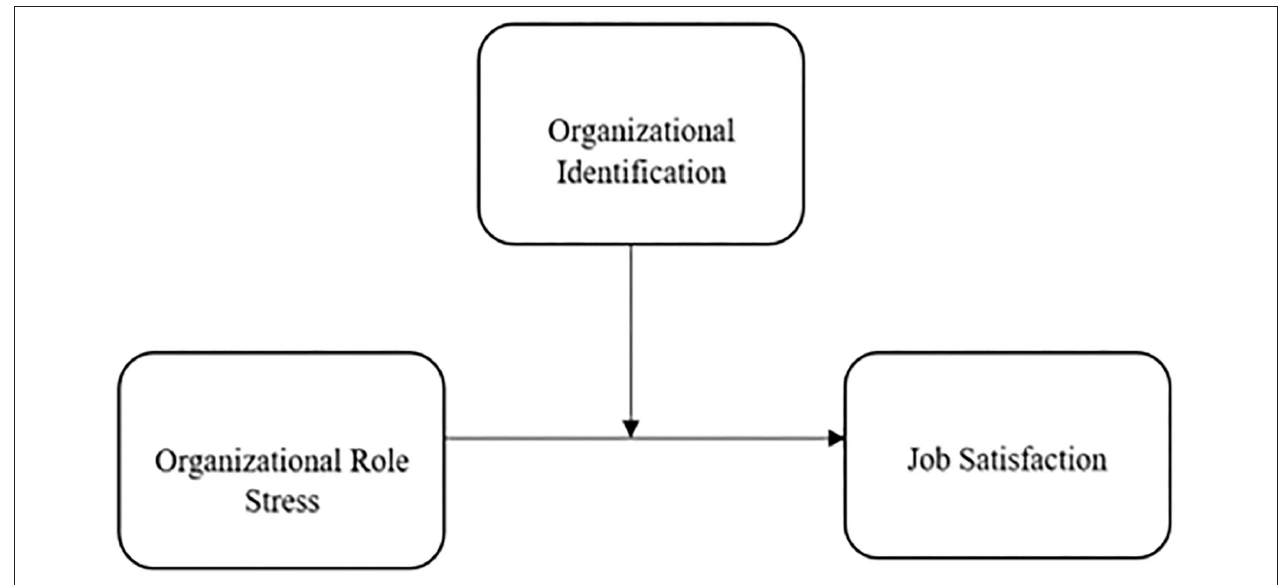
FIGURE 1 | Research